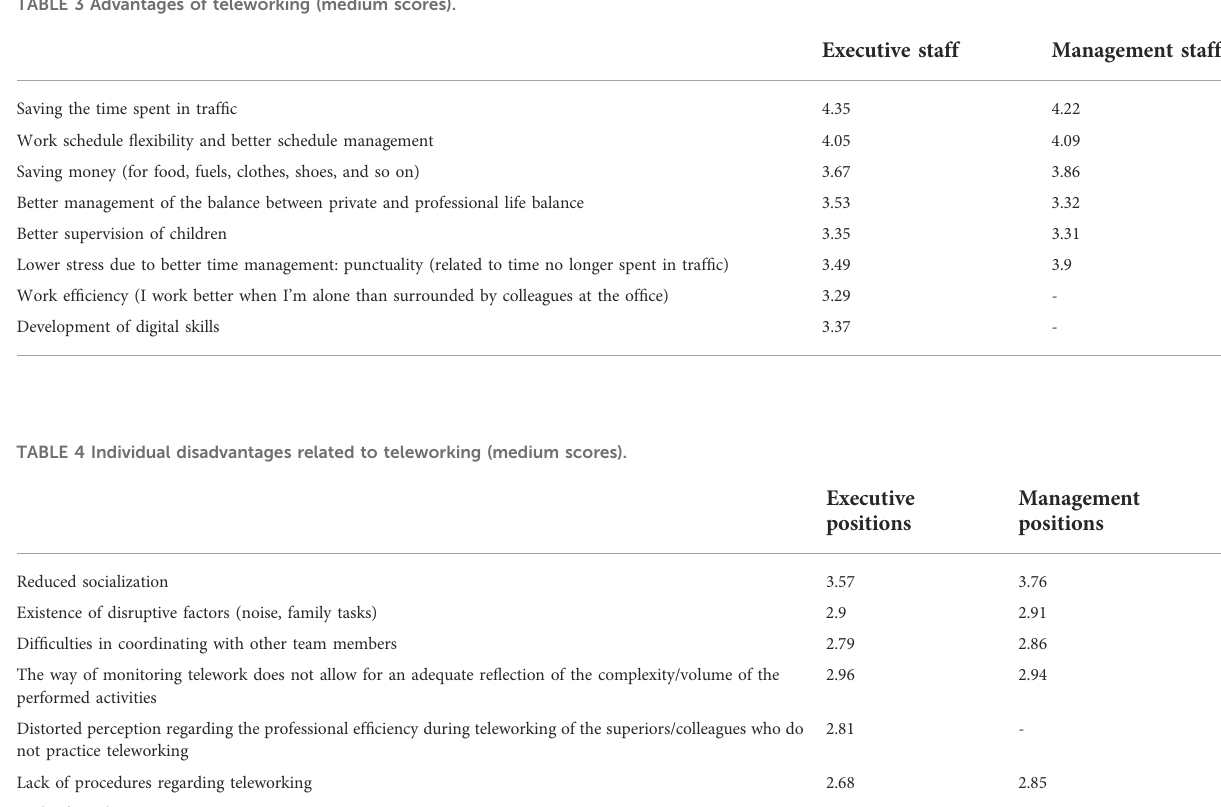
TABLE 3 Advantages of teleworking (medium scores).